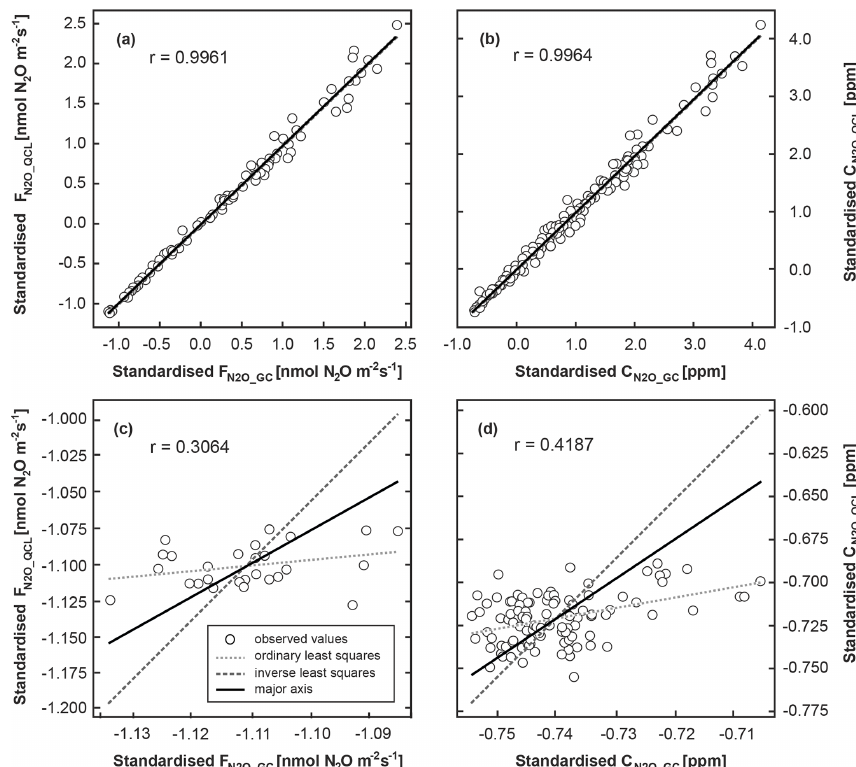
Figure 3. Orthogonal regression analysis of standardised N 2 O concentrations ( C N2O ) and fluxes ( F N2O ) . Data were distinguished by their analytic source of origin, i.e. GC ( C N2O_GC , F N2O_GC ) and QCL ( C N2O_QCL , F N2O_QCL ) . The regression analysis included all C N2O in (a) but only C N2O measured at control sites (AN 0 ) in panel (c) . The orthogonal regression analysis was repeated for standardised F N2O , with (b) showing all F N2O_GC and F N2O_QCL and (d) depicting the orthogonal regression for AN 0 fluxes only. Ordinary least squares (dotted light grey line) resulted from the regression of Y on X and inverse least squares from the regression of X on Y (long dotted dark grey line). The major axis (black line) based on orthogonal regression of Y and X using a principal component analysis. Here, the squared residuals perpendicular to the line are minimised. Note that for the purpose of illustration axes in panels (c) and (d) have different scales. Table S4 provides further